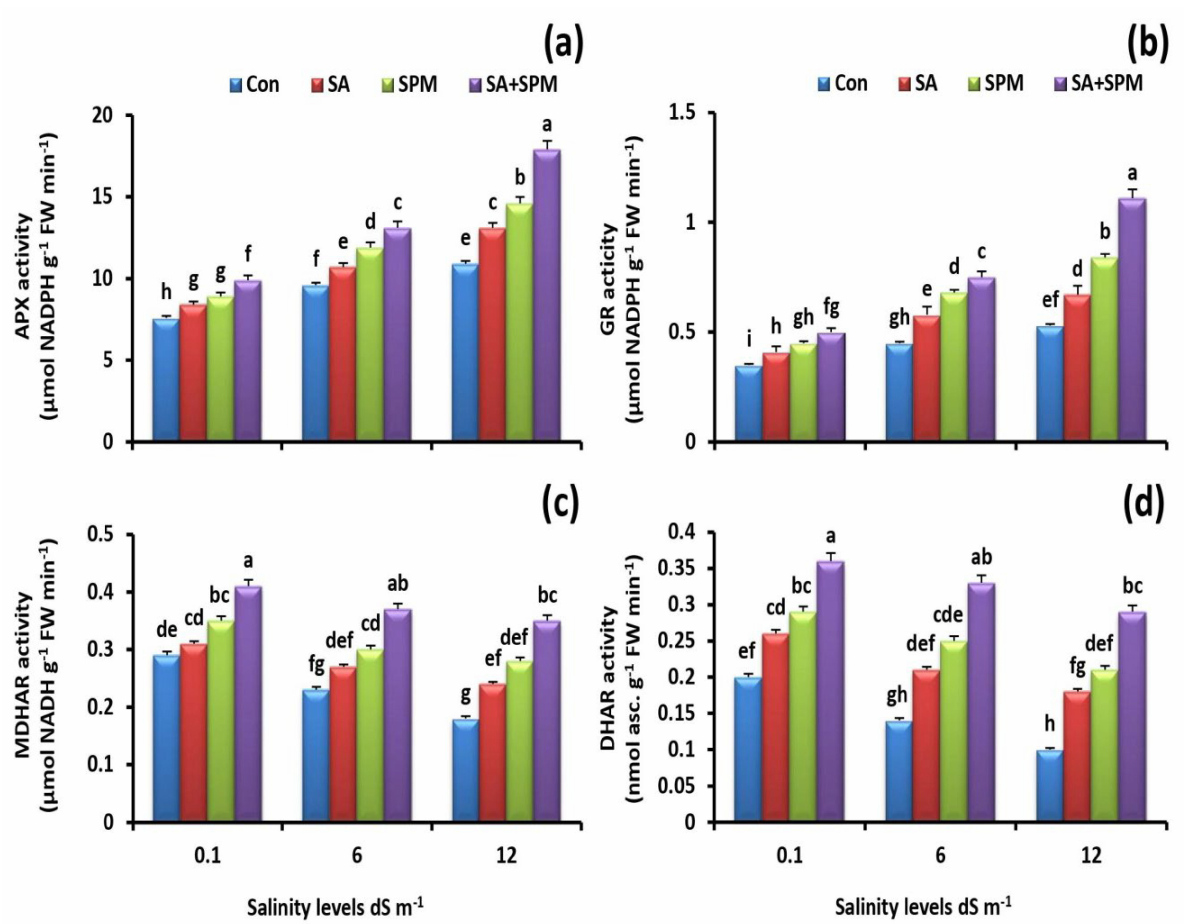
Figure 6. Effect of salicylic acid (SA) and/or spermine (SPM) foliage applications on the activity of ( a ) ascorbate peroxidase (APX), ( b ) glutathione reductase (GR), ( c ) monodehydroascorbate reductase (MDHAR), and ( d ) dehydroascorbate reductase (DHAR) in leaves of wheat plants exposed to non- saline and saline (6.0 and 12.0 dS m − 1 ) conditions. The results showed the mean ± SE of four replicates. Different letters indicate significant differences at ( p < 0.05) level according to Duncan’s test.